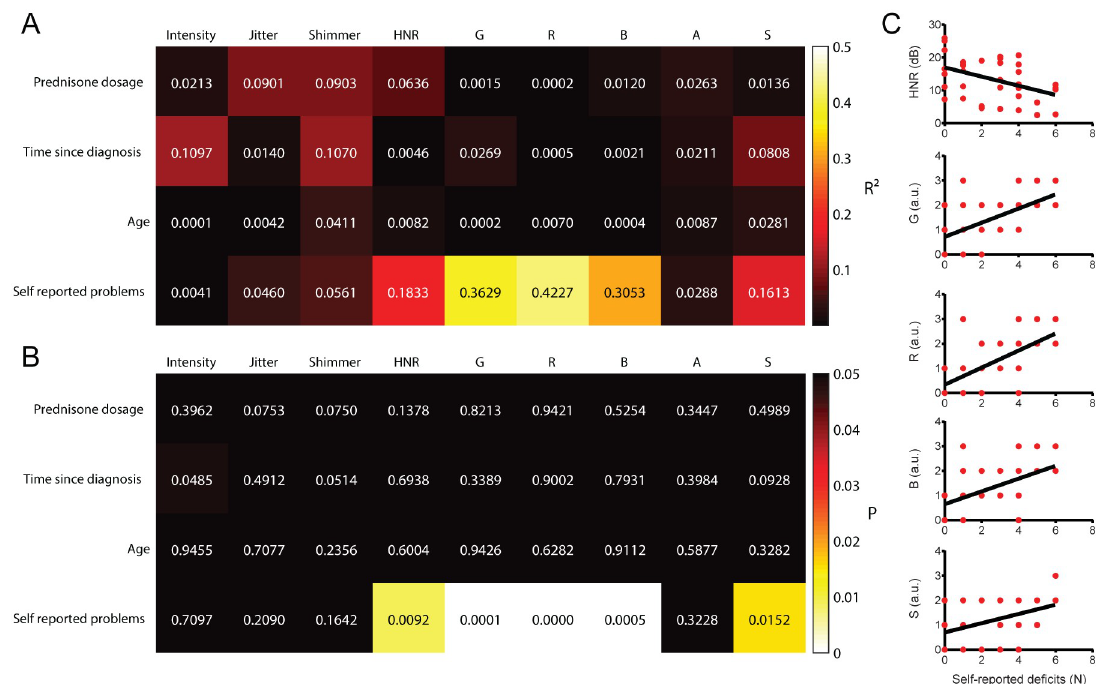
Fig 3. Linear regressions between objective and subjective vocal parameters with potential determinants of dysphonia and self-reported vocal deficits. A: Matrix representing the R 2 values of linear regressions betweenselected variables.Note the highcorrelations(R 2 > 0.15) betweenHNR, G, B, R and S with the number of self-reported vocal deficits. B: Matrix representingthe P values of linear regressionsbetween selectedvariables. Note the significantcorrelations( P < 0.05) betweenHNR, G, B, R and S with the number of self-reportedvocal deficits. C : Scatter-plot representations of the significant correlationsidentified in the correlationmatrices in A and B.